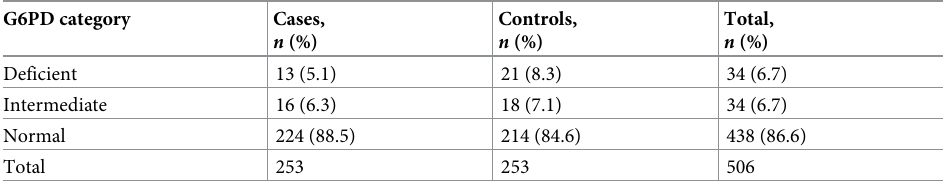
Controls, Total, n (%) n (%) n (%)